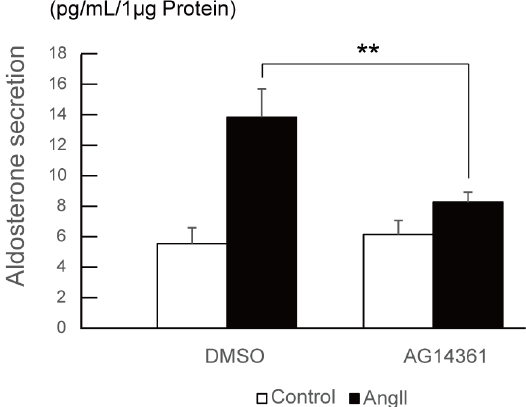
Figure 4. PARP1 inhibitor suppresses aldosterone secretion induced by angiotensin II in H295R cells. The effect of PARP1 inhibitor AG14361 on angiotensin II-induced aldosterone secretion was assessed by qPCR. Cells were treated with 10 μM of AG14361 and 100 nM of angiotensin II for 24 h. Aldosterone was extracted from the conditioned medium of each cells. The concentration of aldosterone measured by ELISA was normalized to the protein content derived from the cells. The error bars indicate standard deviations. The p value was calculated by Student’s t -test ( n = 4). **, p < 0.01.